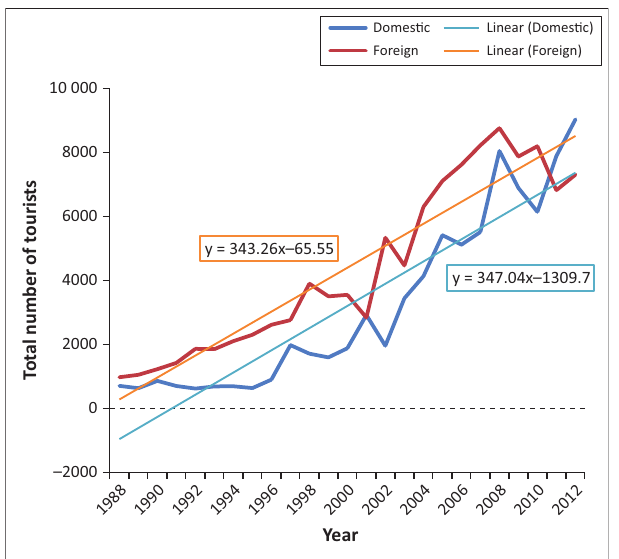
FIGURE 3: Tourist arrival at Mole National Park from 1988 to 2012.